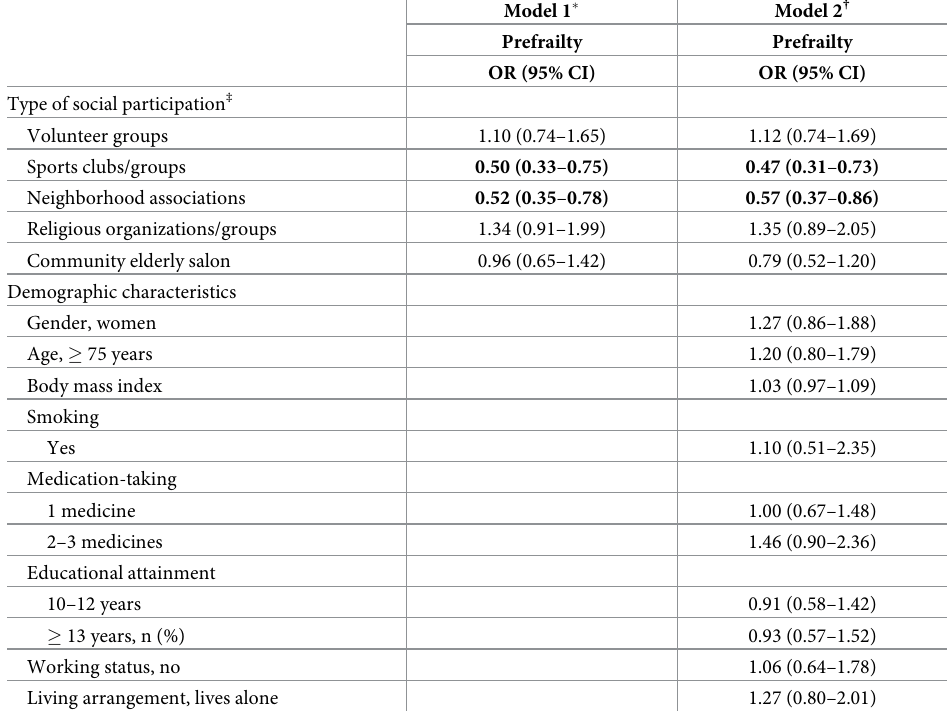
Table 3. Associations between the types of social participation and prefrailty among Japanese older adults (n =